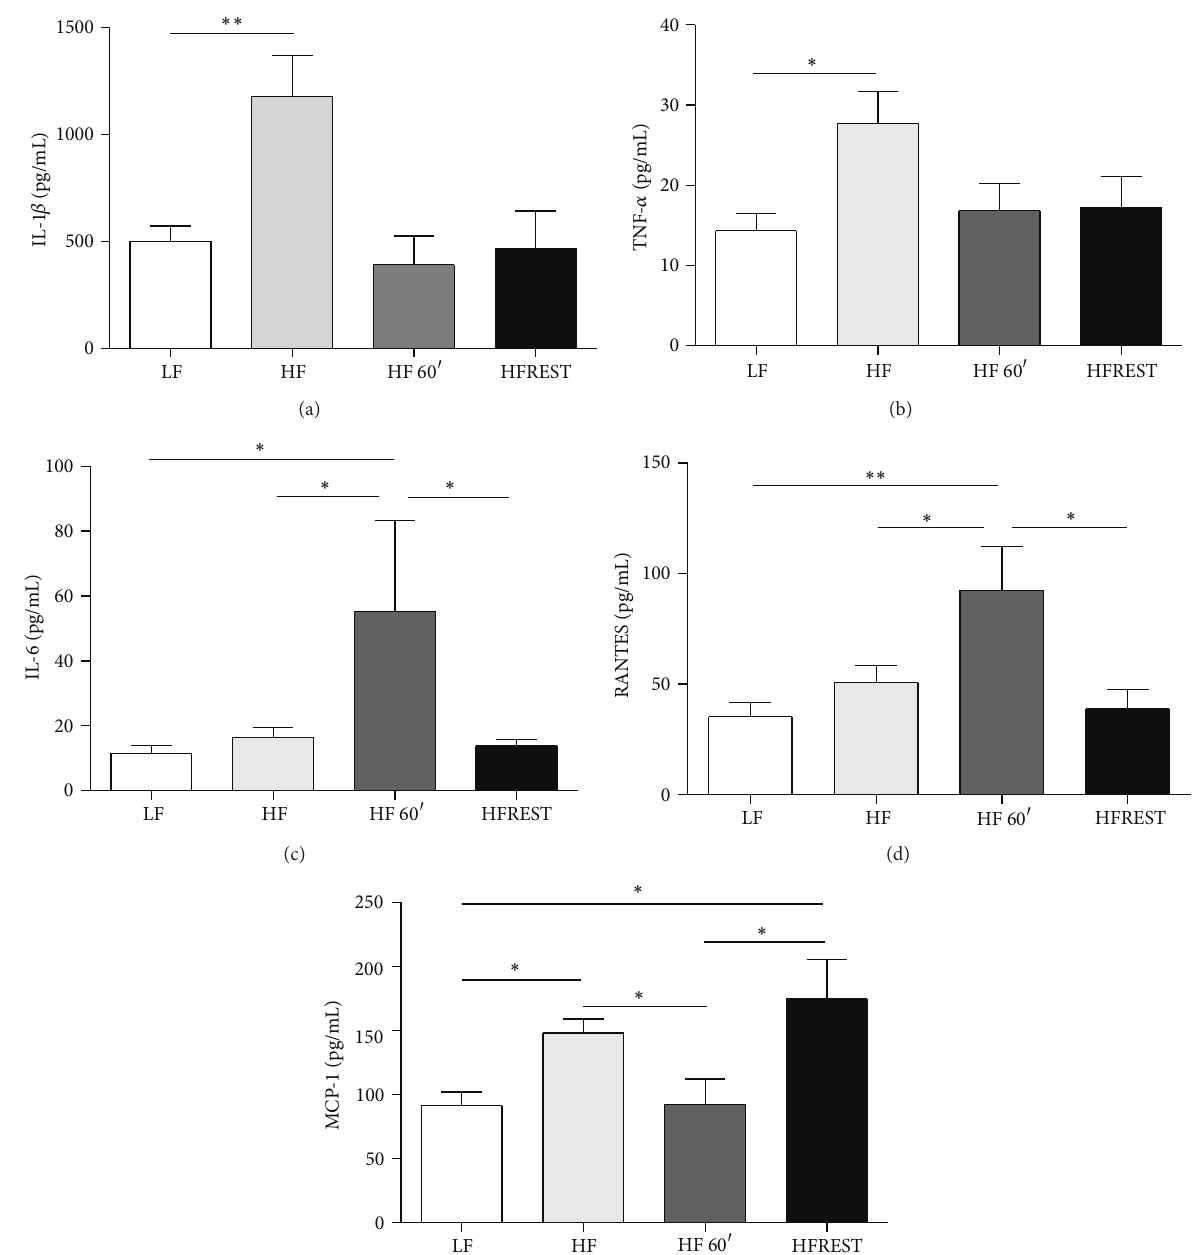
Figure 2: Cytokine concentrations (pg/mL) in mouse serum subjected to control diet (LF, 𝑛 = 12 ), high-fat diet (HF, 𝑛 = 12 ), high-fat diet with exercise 60 󸀠 (HFEX 60 󸀠 , 𝑛 = 8 ), and high-fat diet with 30% food restriction (HFREST, 𝑛 = 8 ). (a) IL-1 𝛽 , (b) TNF- 𝛼 , (c) IL-6, (d) RANTES, and (e) MCP-1. Mean ± SEM. ∗∗∗ 𝑃 < 0.001 , ∗∗ 𝑃 < 0.01 , ∗ 𝑃 < 0.05